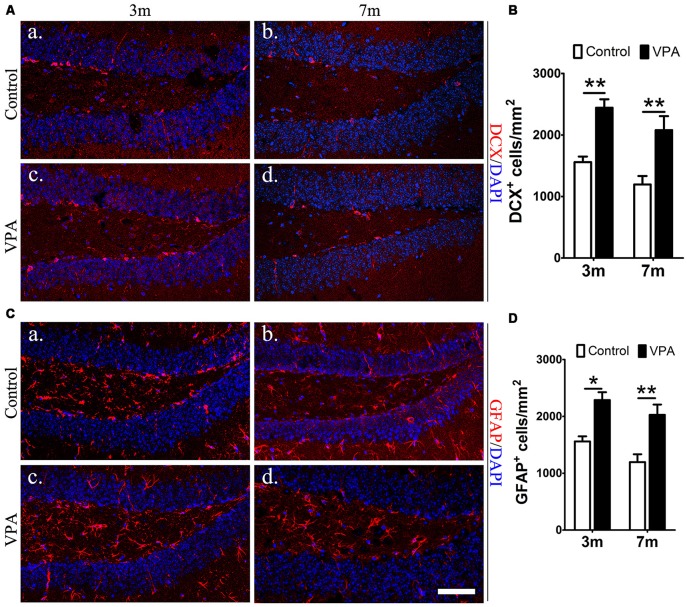
VPA facilitates the differentiation of NSCs. Immunofluorescence staining of doublecortin (DCX+) cells (red) in the SGZ of the DG (Aa–d). Quantification of DCX+ cells; the number of DCX+ cells increased after VPA treatment (B). Immunofluorescence staining of GFAP+ cells (red) in the SGZ of the DG (Ca–d). Quantification of GFAP+ cells; the number of GFAP+ cells increased after VPA treatment. Nuclei are stained in blue with DAPI (D). *P < 0.05, **P < 0.01, scale bar = 50 μm.